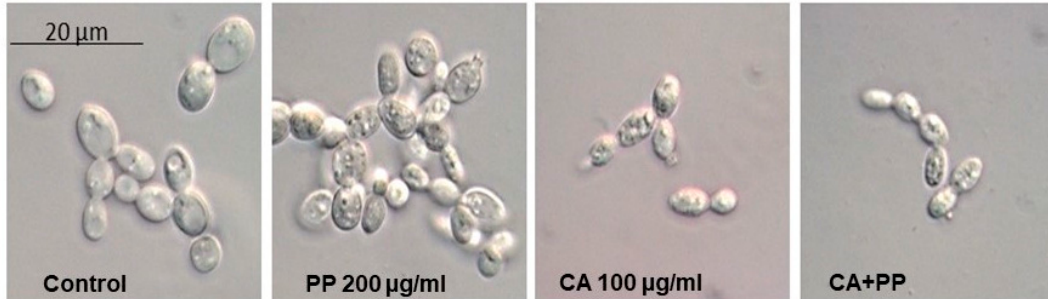
Figure 3. Morphological changes in C. albicans SC5314 blastoconidia induced by the individual addition of CA and PP or in combination. YPD-grown exponential cells (OD 600 = 0.8) were exposed for 3 h at 37 °C to the indicated concentrations of CA and PP. An untreated sample was maintained as a control. Two similar representative images from each treatment were taken by means of Nomarsky interferential contrast.